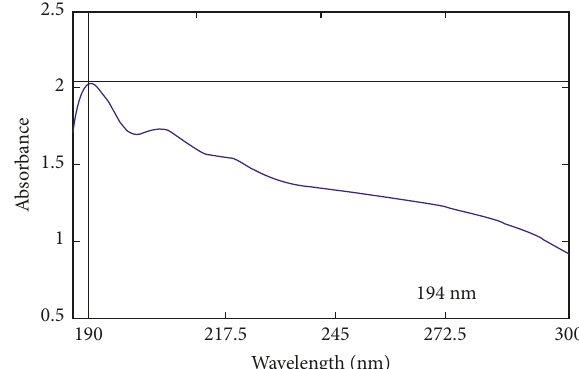
Figure 9: UV-Vis (arcing in DW + PVA for 12 min, peak at 194